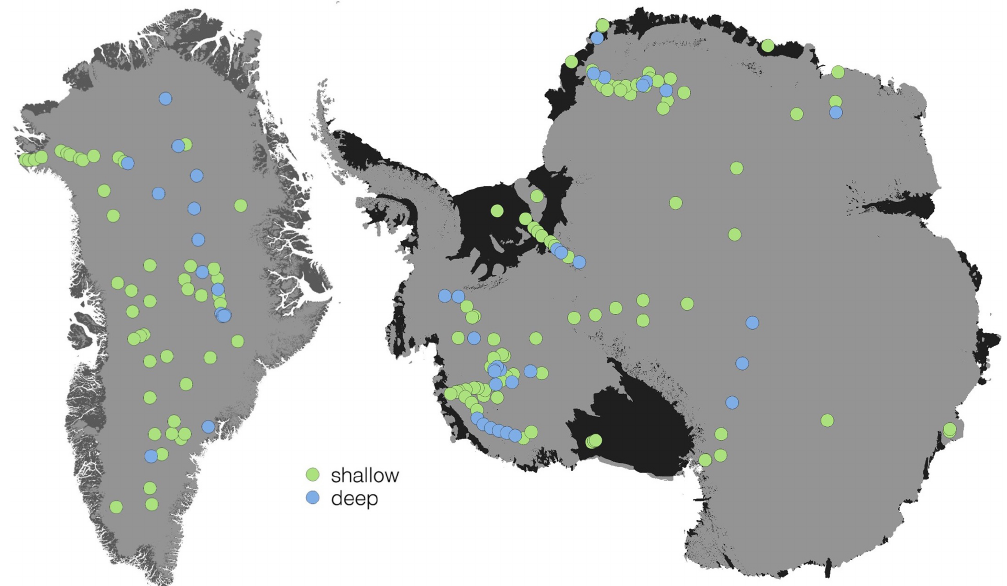
Figure 3. Locations of shallow (green) and deep (blue) firn cores. Firn cores are classified as shallow if they reach the 550kgm − 3 density horizon and deep if they extend to the 830kgm − 3 density